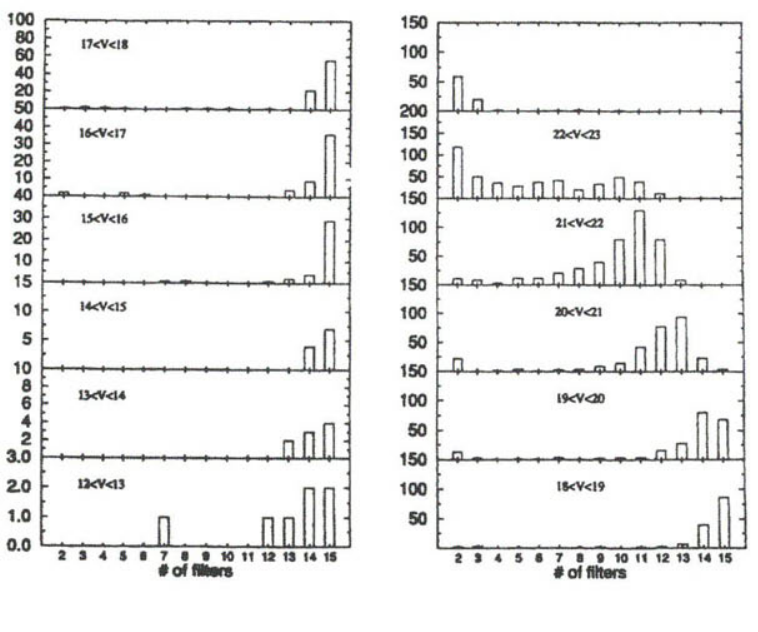
Fig. 3. SA 92 # distribution by magnitude and